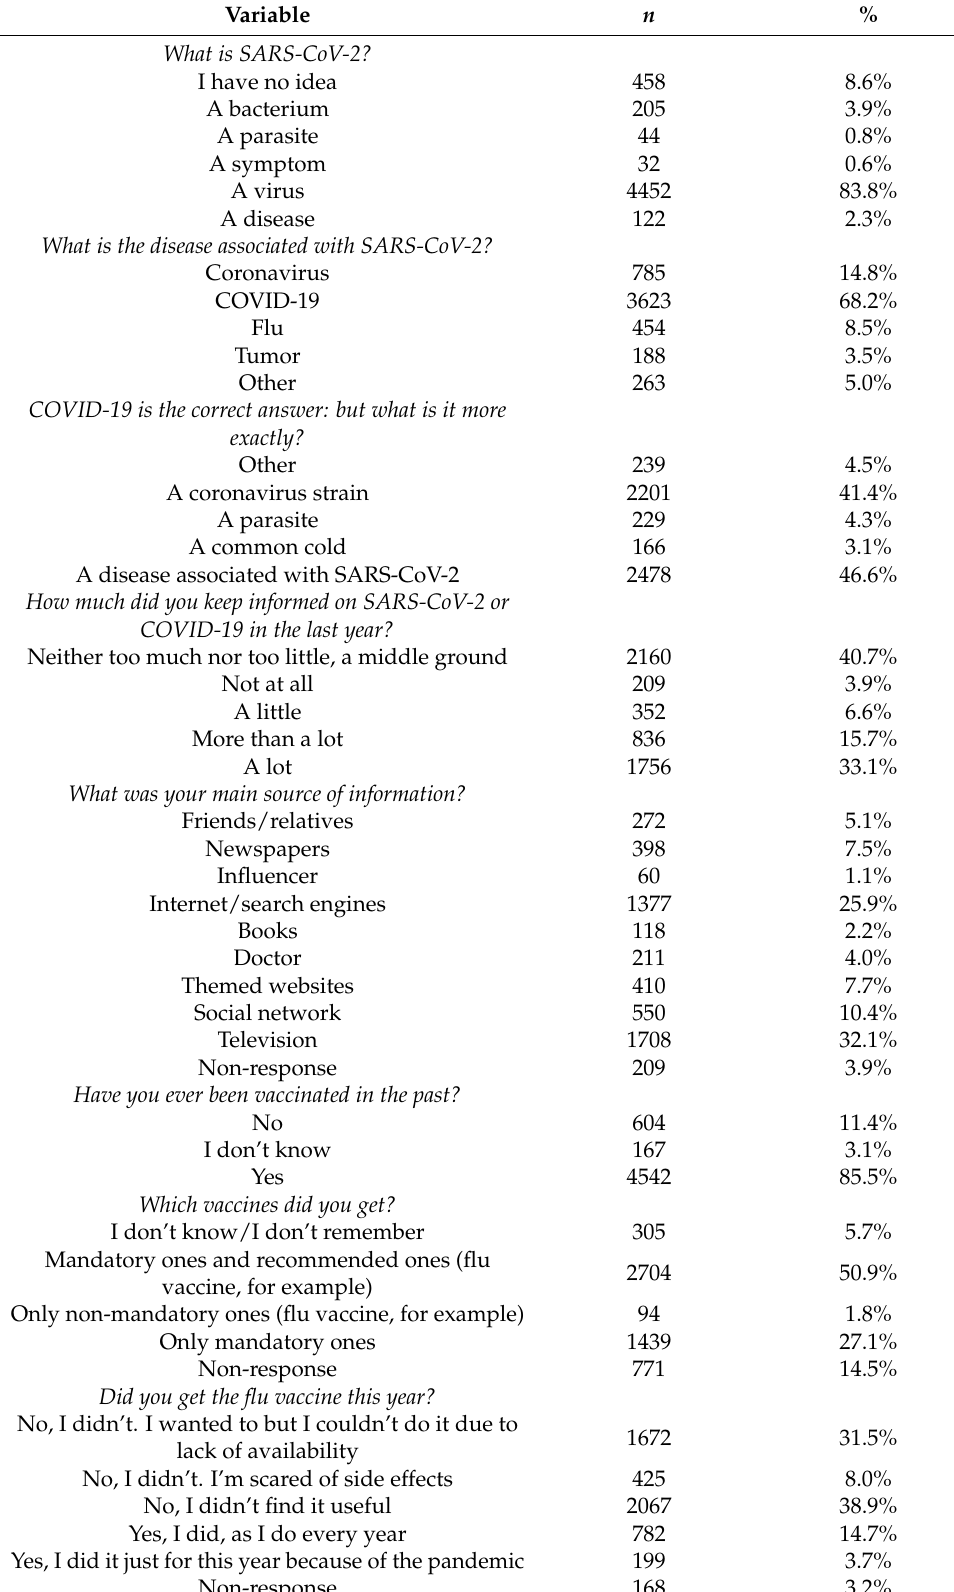
Table 2. Attitudes and